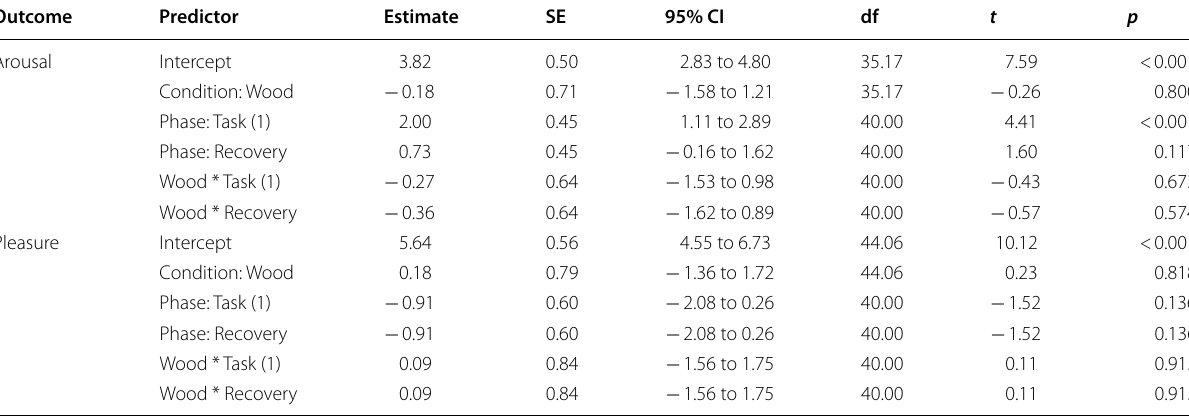
Significant predictors ( p < 0.05) are shown in